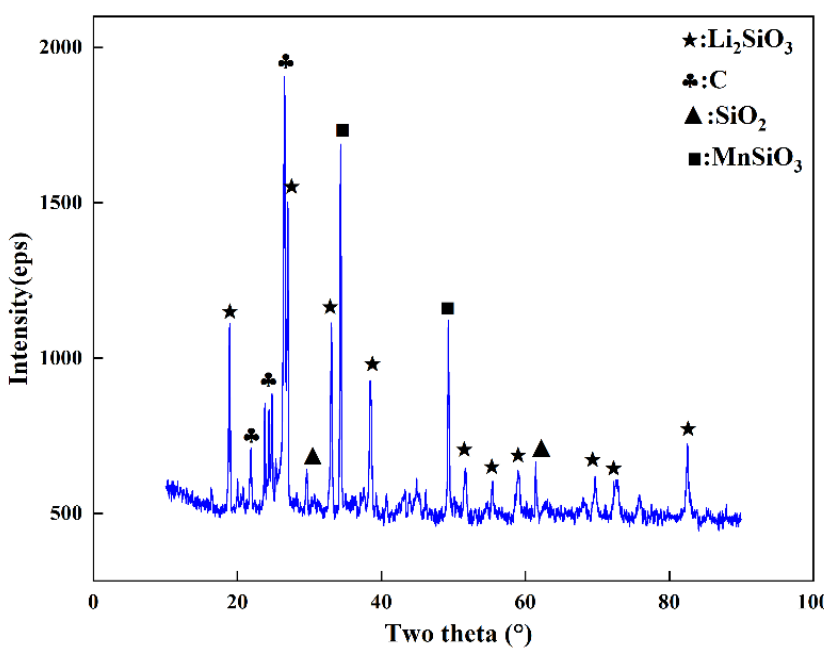
Figure 4. XRD pattern of the condensate.